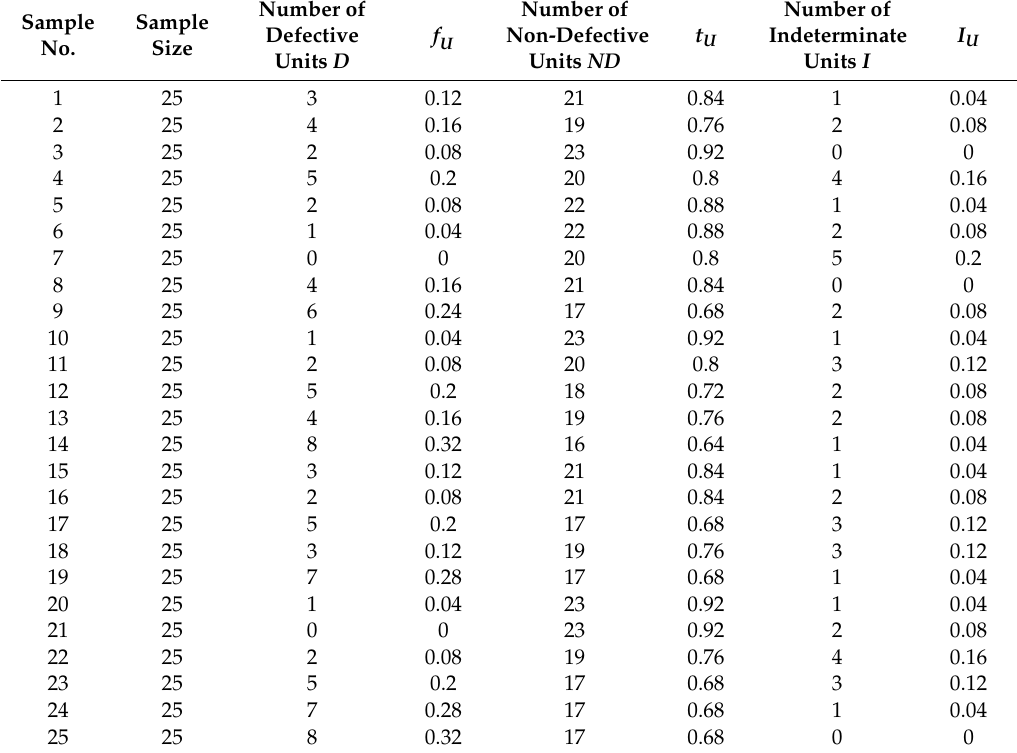
Table 1. Neutrosophic data when n = 25.